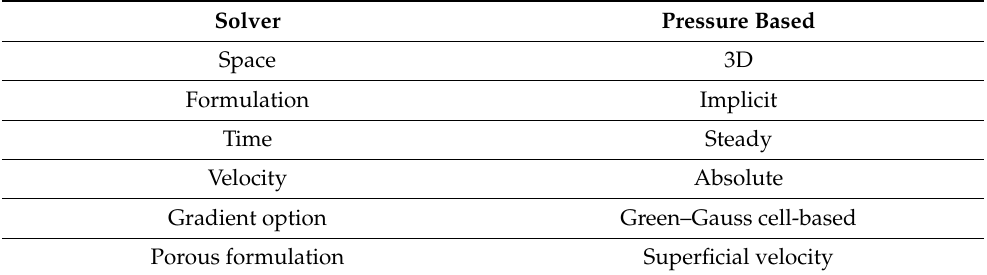
Table 3. Setup of Solver in PHOENICS.